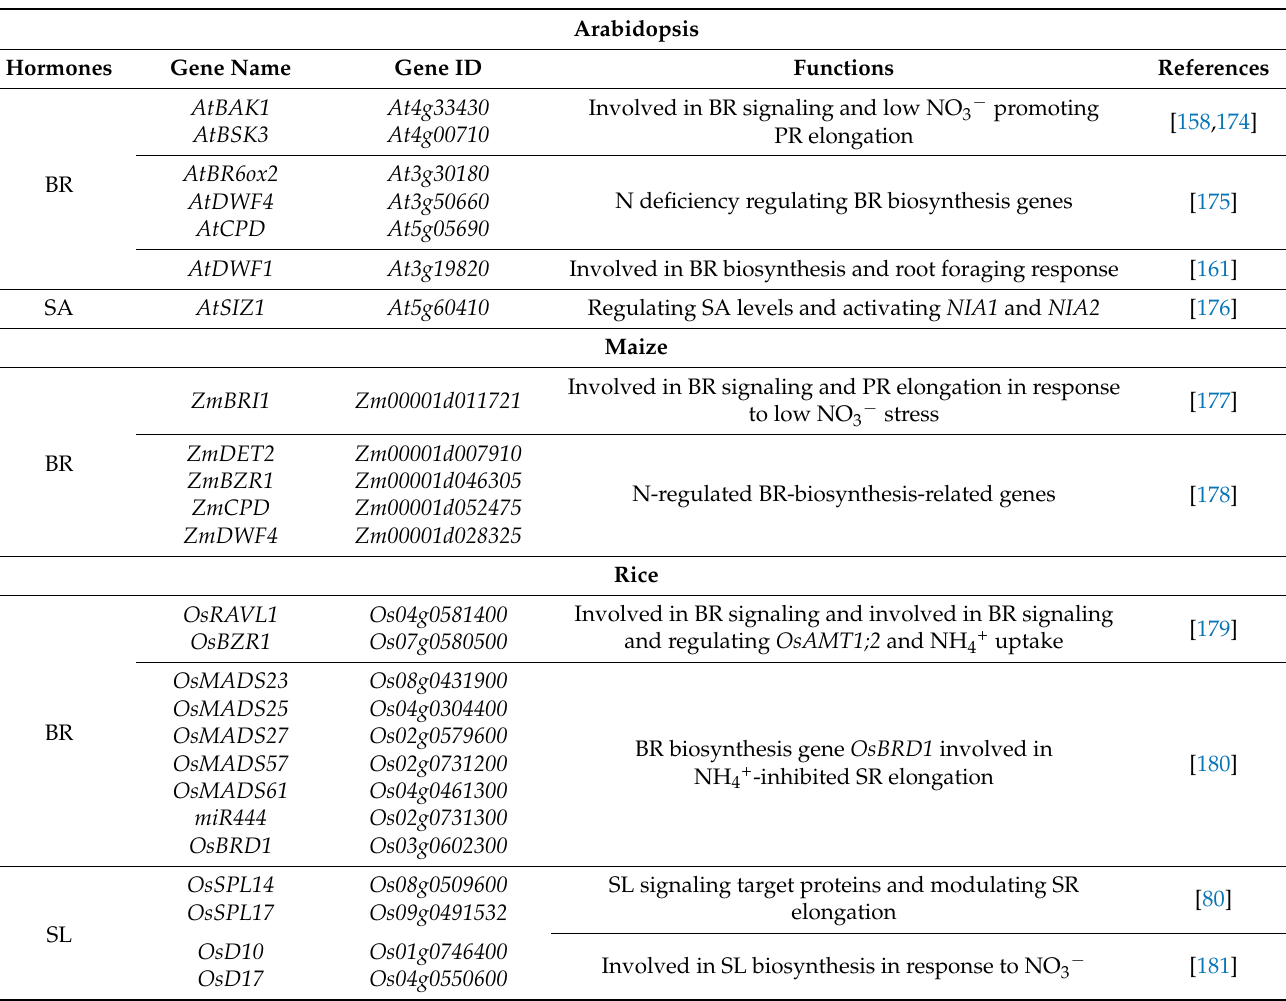
Table 5. List of genes and their roles associated with N stress and BR, SA, and SL in Arabidopsis, maize, and